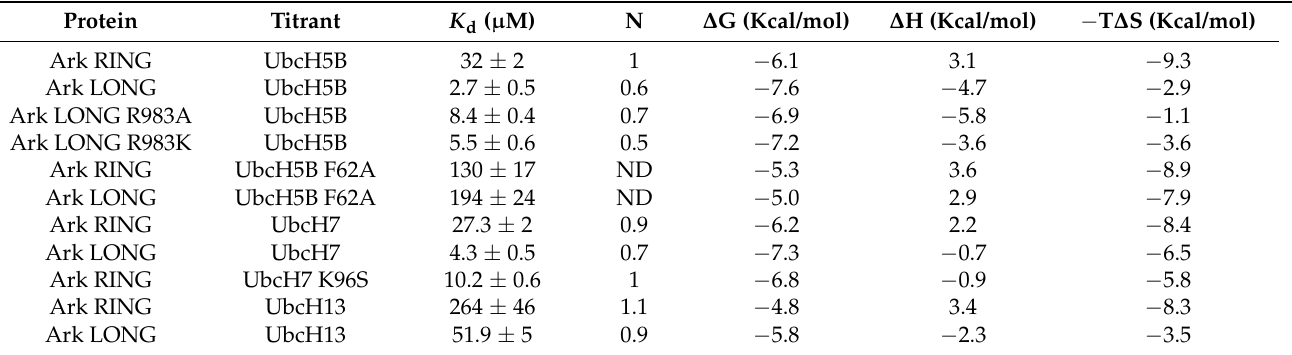
Each value is the average of at least three independent measurements. Abbreviations: N, stoichiometry; K d , disso- ciation constant; ∆ H, ∆ S, and ∆ G, changes in binding enthalpy, binding entropy, and Gibbs energy,